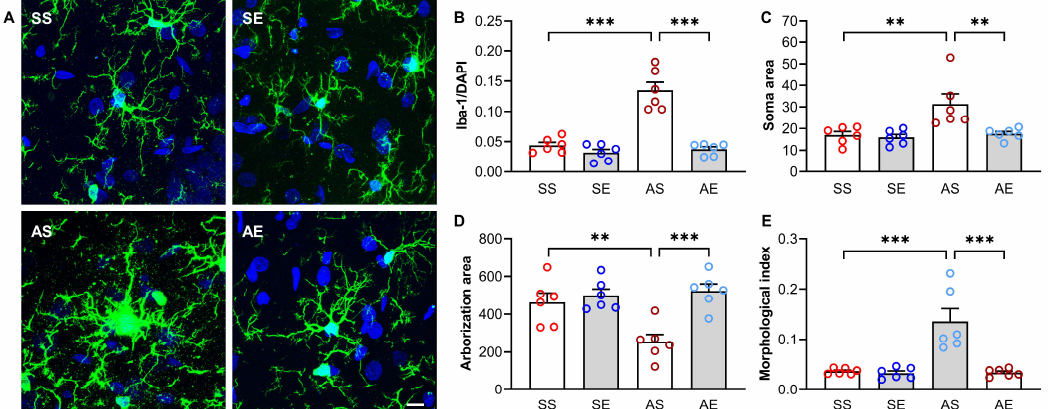
Figure 4. Treadmill exercise decreased the AIE-induced excessive activation of microglia in the hippocampus of young adult rats. ( A ) The representative microscope imaging of Iba-1 + cells in the hippocampus of rats in each group. Green, Iba-1 + cells. Blue, DAPI. Scale bar = 10 µ m. ( B ) The Iba-1/DAPI in the hippocampus of rats in each group. The Iba-1/DAPI was increased in the AS rats compared to the SS rats. The increased Iba-1/DAPI was prevented by treadmill exercise training (*** p < 0.001, n = 6). ( C ) The soma area of Iba-1 + cells in the hippocampus of rats in each group. The soma area of Iba-1 + cells was increased in the AS rats compared to the SS rats. The increased soma area of Iba-1 + cells was prevented by treadmill exercise training (** p < 0.01, n = 6). ( D ) The arborization area of Iba-1 + cells in the hippocampus of rats in each group. The arborization area of Iba-1 + cells was decreased in the AS rats compared to the SS rats. The decreased arborization area of Iba-1 + cells was prevented by treadmill exercise training (** p < 0.01, *** p < 0.001, n = 6). ( E ) The morphological index of Iba-1 + cells in the hippocampus of rats in each group. The morphological index of Iba-1 + cells was increased in the AS rats compared to the SS rats. The increased morphological index of Iba-1 + cells was prevented by treadmill exercise training (*** p < 0.001, n =